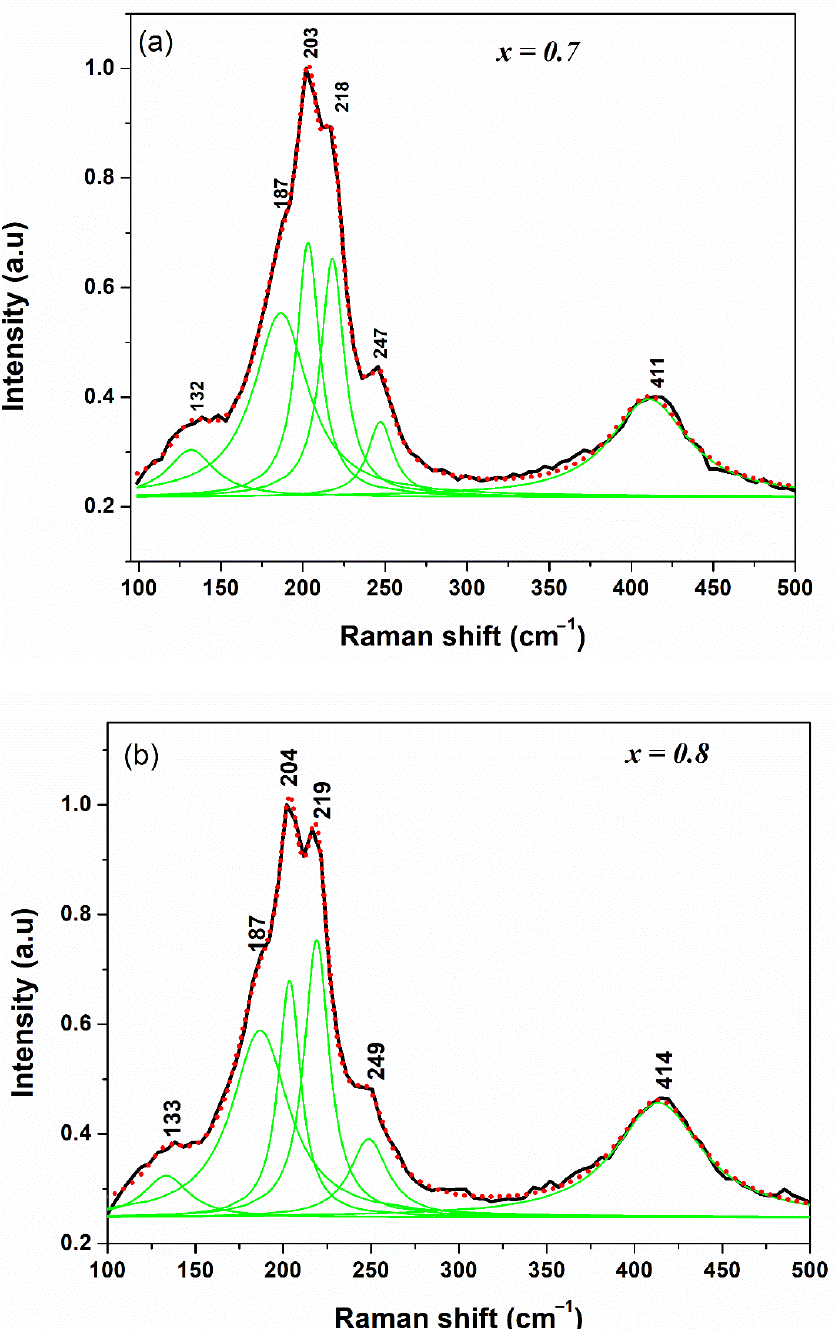
Figure 5. Raman spectrum of Cu 2 Zn(Sn 0.3 Si 0.7 )Se 4 ( x = 0.7) ( a ) and Cu 2 Zn(Sn 0.2 Si 0.8 )Se 4 ( x = 0.8) ( b ) samples with wurtz-stannite structure. Contribution of the different peaks deduced from the fit with Lorentzian curves (green lines).